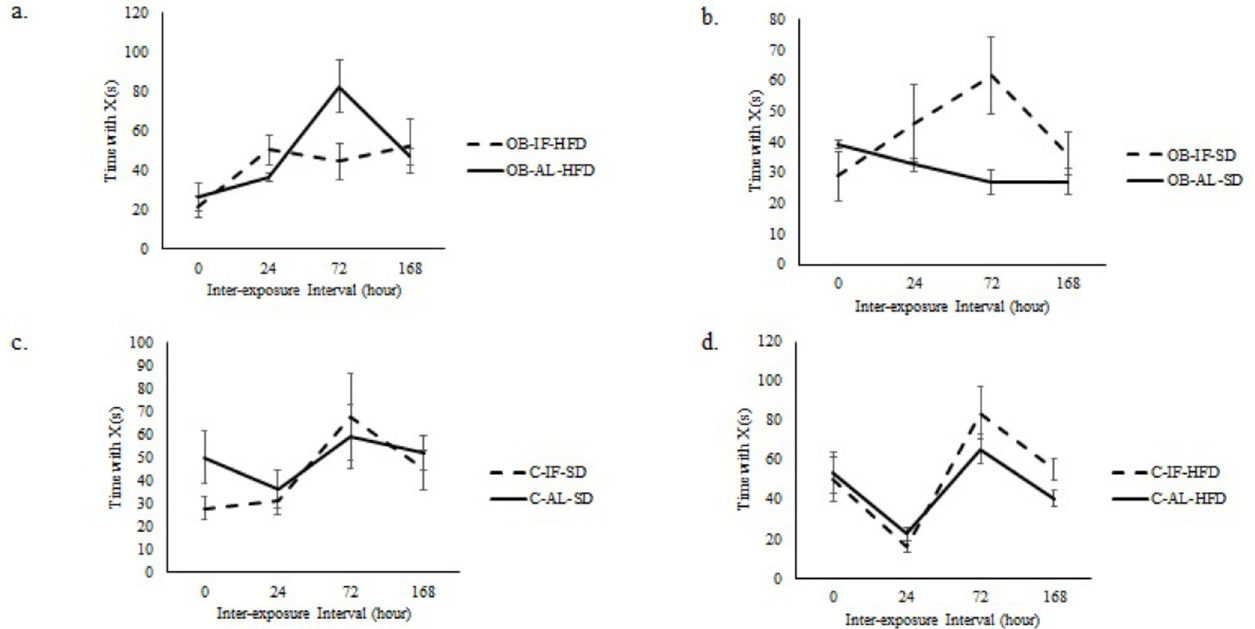
Fig 4. Time spent with novel objects. Obese (OB); Non-obese controls (C); IF: intermittent fasting; AL: ad libitum ; HFD: high-fat diet; SD: standard diet. Error bars represent standard error.